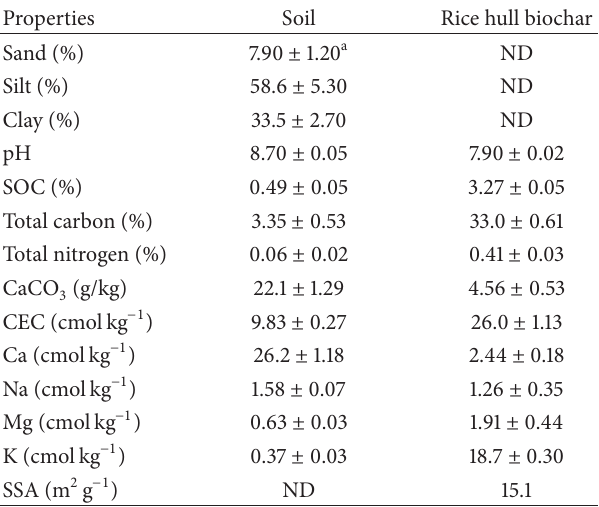
Table 1: General properties of the studied soil and the biochar.